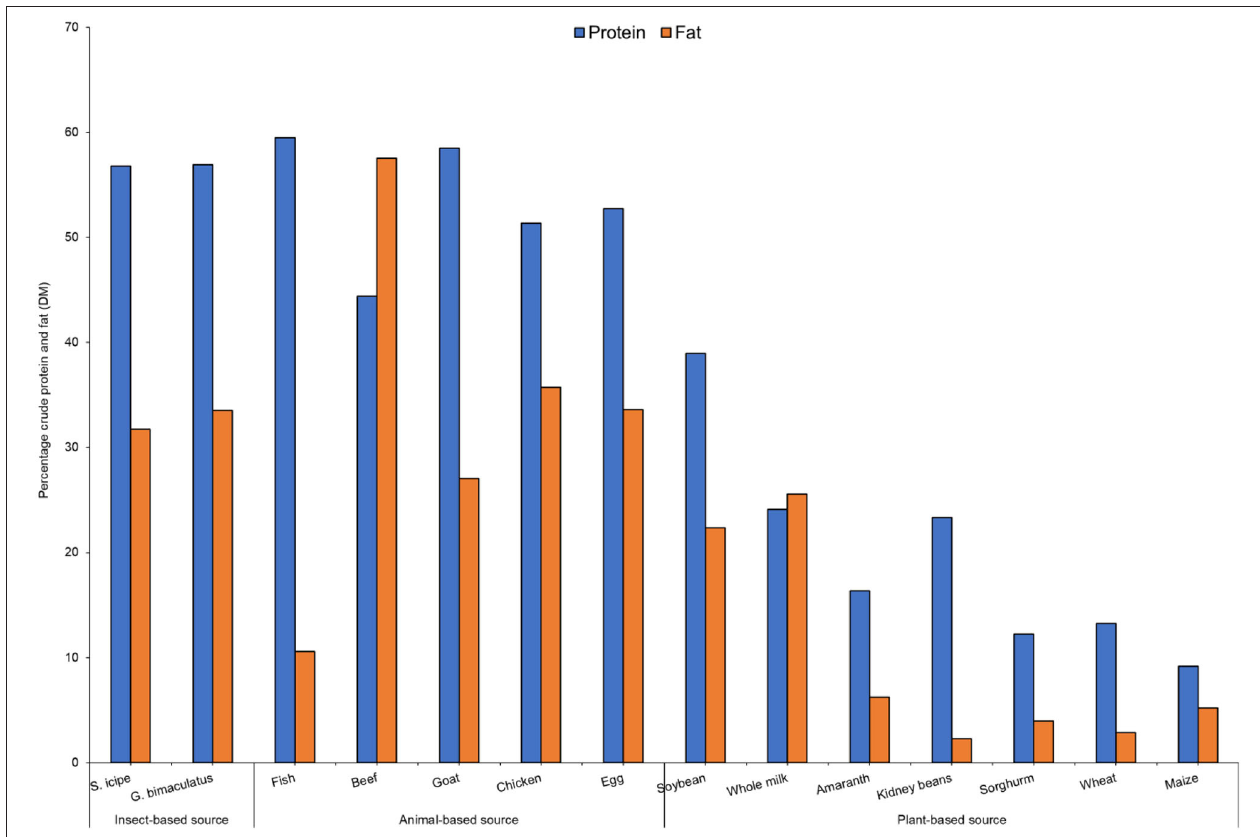
FIGURE 1 | Comparative analysis of percentage crude protein and fat content [on dry matter basis—DM] of crickets ( Scapsipedus icipe and Gryllus bimaculatus ), and selected plants and animal sources. Data for plant and animal sources was extracted from FAO/GoK (31).